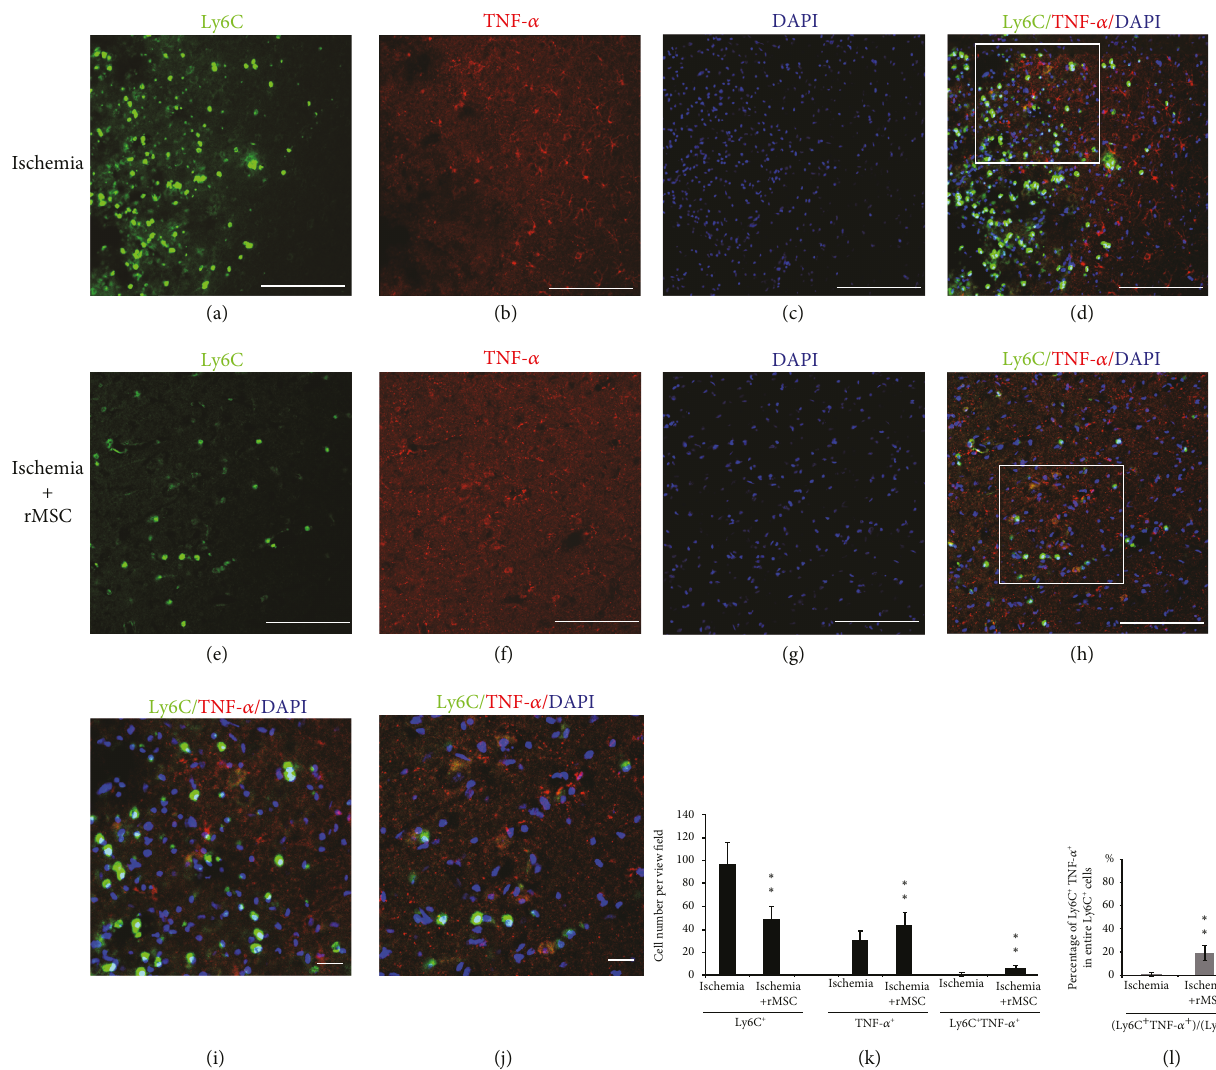
Figure 5: MSC increases the proportion of Ly6C + cells coexpressing TNF- α in the ischemia core of the cortex at day 2. (a – d) Distribution of Ly6C + and TNF- α + cells in the infarct area before MSC treatment. (e – h) Distribution of Ly6C + and TNF- α + cells in the infarct area after MSC treatment. (a, e) Ly6C staining. (b, f) TNF- α staining. (c, g) DAPI nucleus staining. (d) Double-stained Ly6C + /TNF- α + cells scattered in the infarct area 2 days after dMCAO. (h) Ly6C + /TNF- α + cells in the infarct area 2 days after MSC transplantation. (i) The magni fi ed image of the square in (d). (j) The magni fi ed image of the square in (h). (k) The quantities of Ly6C + , TNF- α + , and TNF- α + /Ly6C + double-positive cells were increased in the infarct area. (l) The percentage of TNF- α + /Ly6C + double-positive cells among the entire Ly6C + cells was increased by MSC treatment. ( ∗ p < 0 05 and ∗∗ p < 0 01 , as compared with the ischemia vehicle group). Arrow: double-labeled cells. n = 5 ; scale bar: (a – h) 250 μ m, (i, j) 50 μ